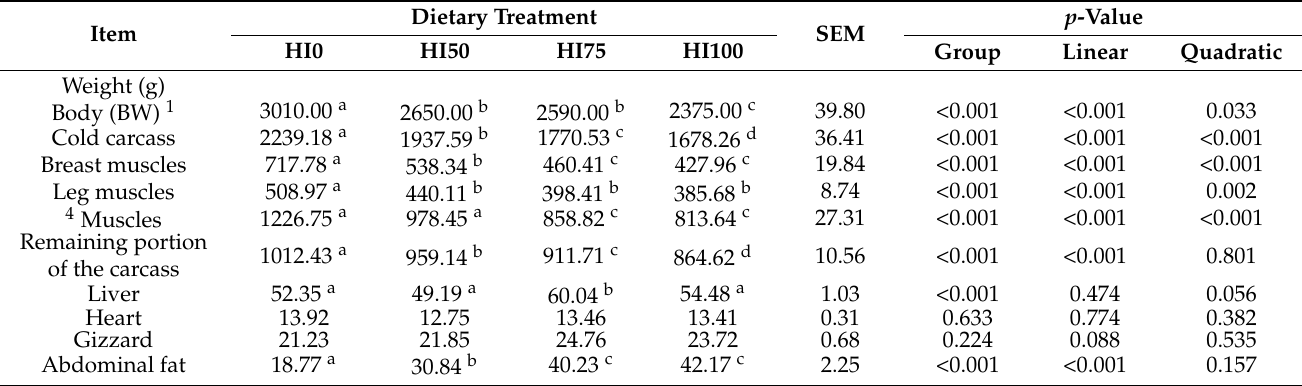
Table 4. Body weight (BW) 1 and the weights of carcass, muscles, fat and selected internal organs in broiler chickens fed diets with different levels of full-fat Hermetia illucens (HI) 2 larvae meal (g, arithmetic mean, SEM 3 ; values on d 42; n = 16). Item